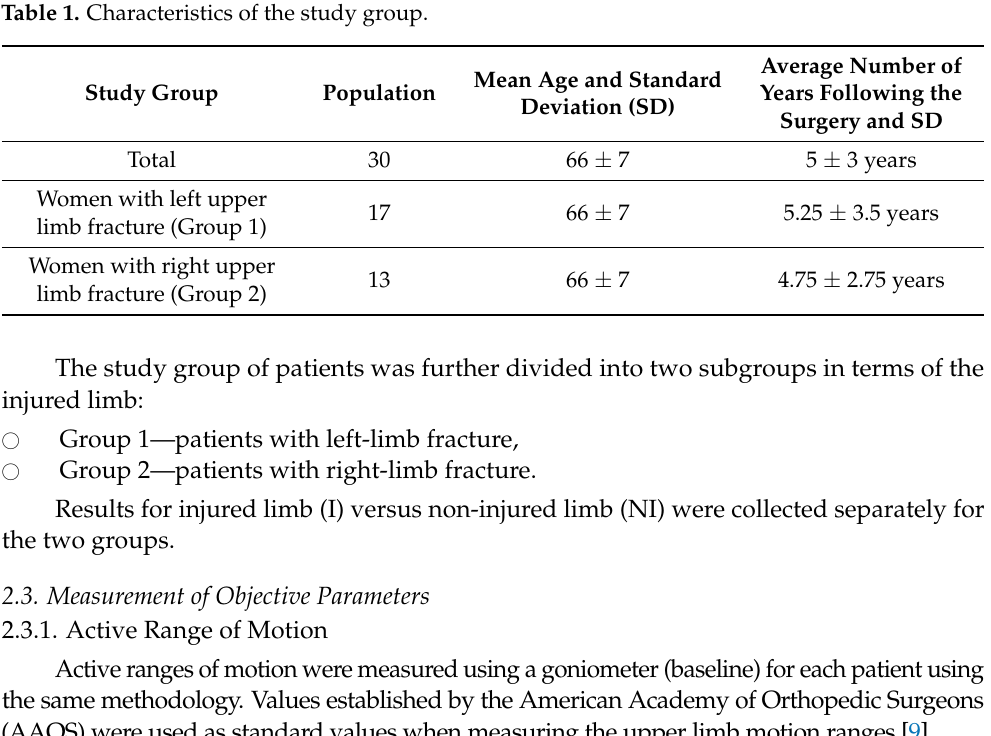
Table 1. Characteristics of the study group.